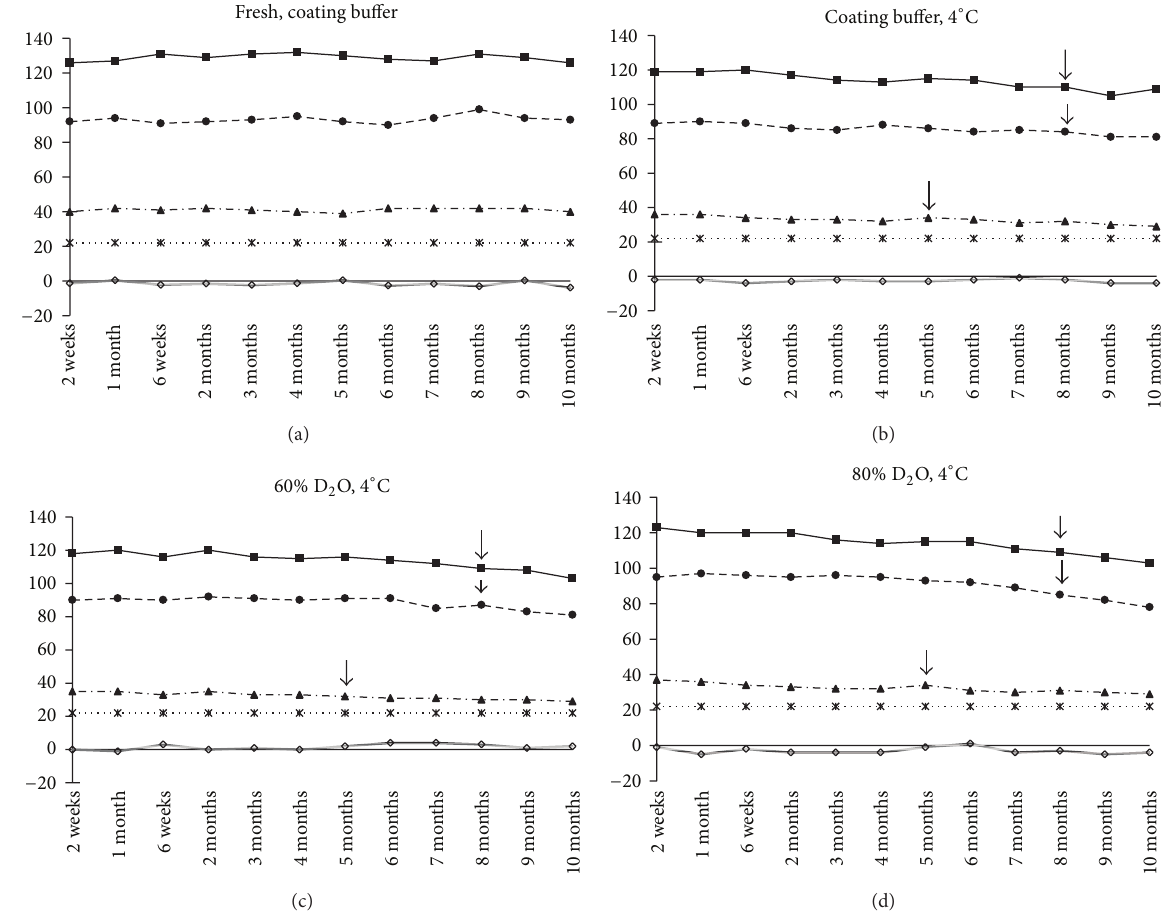
Figure 1: Thermostability of rp26 ELISA at 4 ∘ C. 𝑃𝑃 value of strong positive serum ( ◼ ), medium positive serum ( e ), and weak positive serum ( 󳵳 ) was compared with fresh ELISA. Duration of thermostability is indicated by arrow ( ↓ ) against each serum. Beyond this point, significant deviation in 𝑃𝑃 value was observed in comparison to fresh plate ( 𝑃 = 0.03 ). No significant difference exists in 80% D 2 O versus H 2 O coating buffer, 60% D 2 O versus H 2 O coating buffer, and 60% D 2 O versus 80% D 2